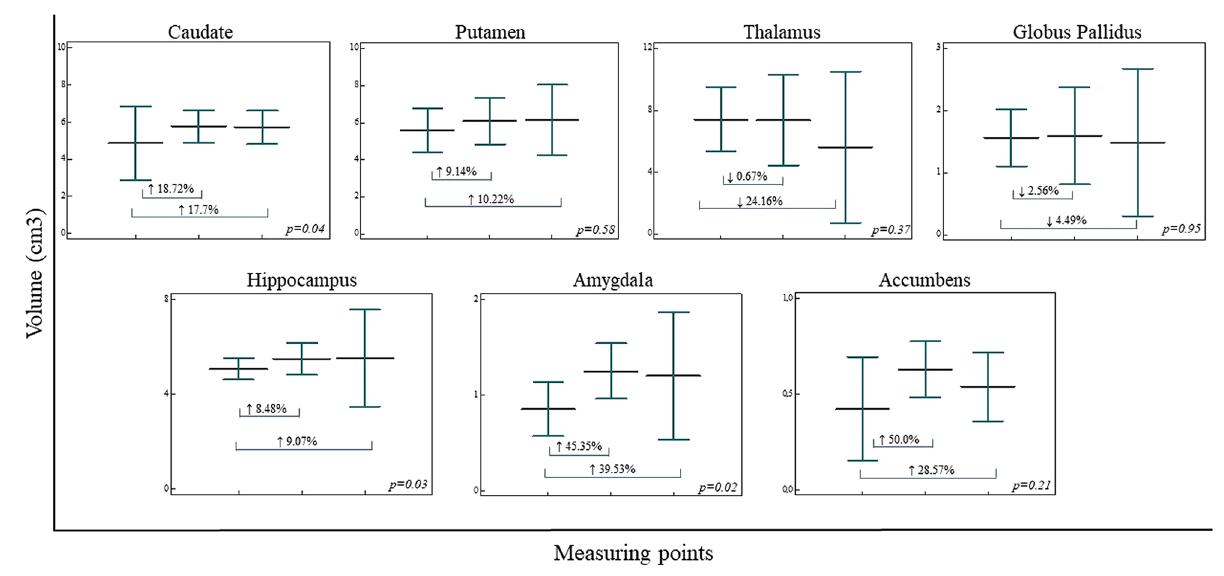
Figure 4. Subcortical structures volumetric analysis in three measuring points (prior to DBS, 1 year after DBS, and 7 years after DBS). Significant volume increase of caudate, hippocampus, and amygdala were presented, while putamen and accumbens volumes presented a trend of volume increase during three measuring points. Both globus pallidus and thalamus volume decreased over time. Vertical bars, standard deviatio